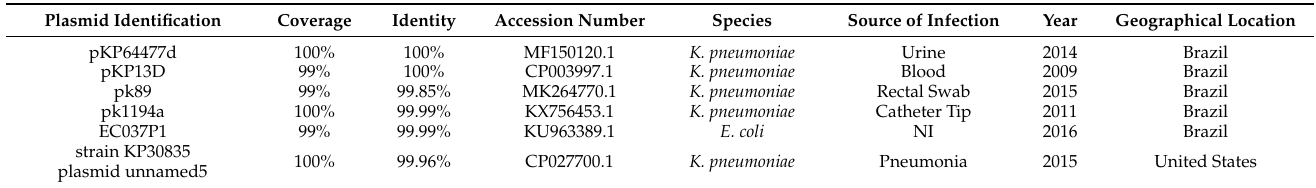
Table 2. Nucleotide sequences comparison with IncX3 found in KP411 strain with plasmids deposited at